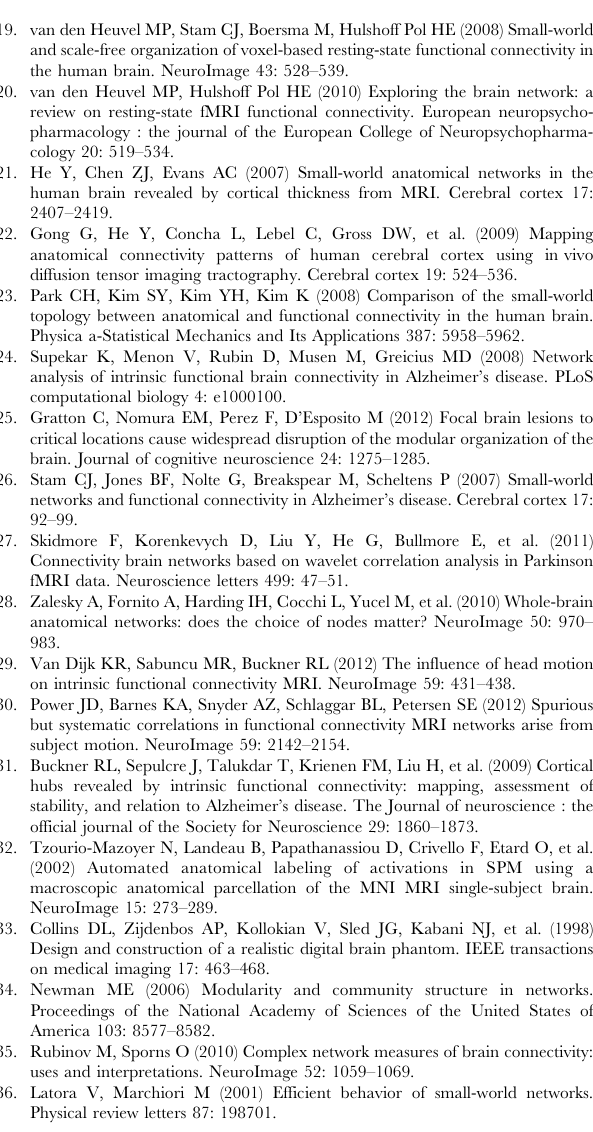
Figure S1 Representation of the brain parcellation conducted in the present analysis. A) Parcellation of the whole brain into 343 ROIs. B) Parcellation of the right caudate. Figure S2 The z-degree in the cuneus, calcarine and posterior cingulate cortex as a function of the sparsity for ROIs where we observed significant group effects comparing controls (blue circles) and PD patients (red squares). Critically, the reported effect does not depend on the sparsity. Figure S3 Between group effects in degree centrality. Voxel- level (cluster defining threshold p = 0.005; cluster size threshold k . 65; cluster wise significance p= 0.05 uncorrected) and ROI- level data (blue areas; considering only nodes in modules 4 and 6) are presented. A) Regions with a larger degree in healthy controls compared to patients. B) Regions with a larger degree for PD patients compared to controls.